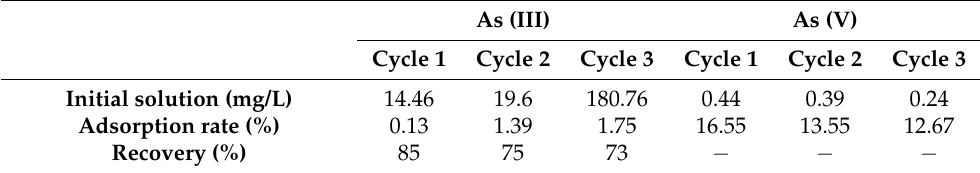
Table 3. Regeneration cycles of